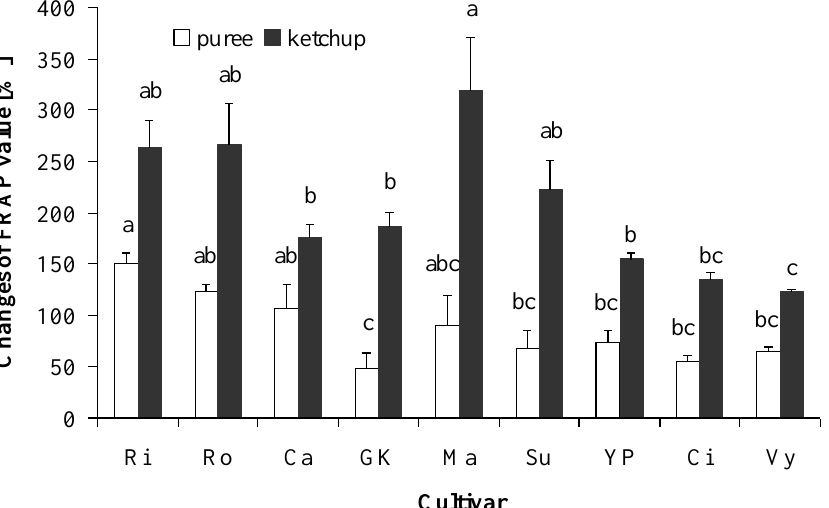
Figure 5. Relative variation in total antioxidant capacity measured as FRAP value of tomato culti- vars as affected by processing to puree and ketchup (Ri—‘Rilia’, Ro—‘Roma’, Ca—‘Campbell-28’, GK—‘Goldene Königin’, Ma—‘Marmande’, Su—‘Suso’ F1, YP—‘Yellow Pearshaped’, Ci—‘CIMA’, Vy—‘Vyta’). The changes were calculated based on data presented in Table 1. The relative variation in antioxidant capacity of fresh tomato fruits is 0 by definition. Different letters indicate significant differences within each processing method for cultivars by Duncan test at p ≤ 0.05, n = 16.